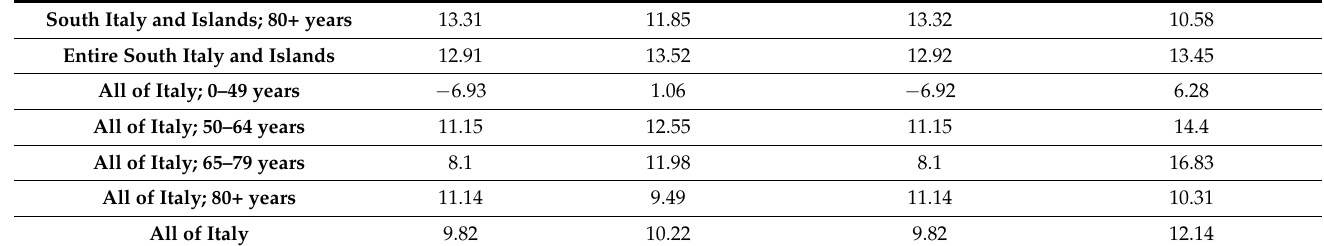
Supplementary Table S1a. Excess mortality estimates using different models according to region for the year 2020. The 95% confidence intervals are included for the three models.